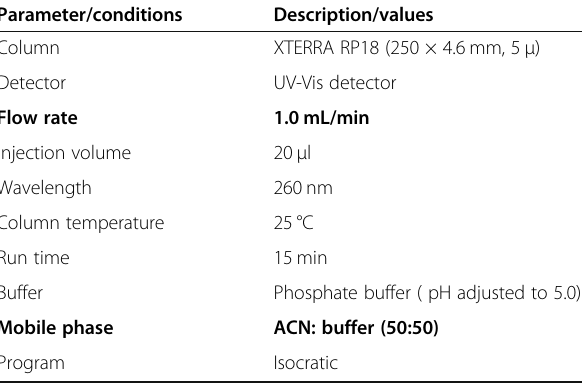
Table 5 Optimized chromatographic